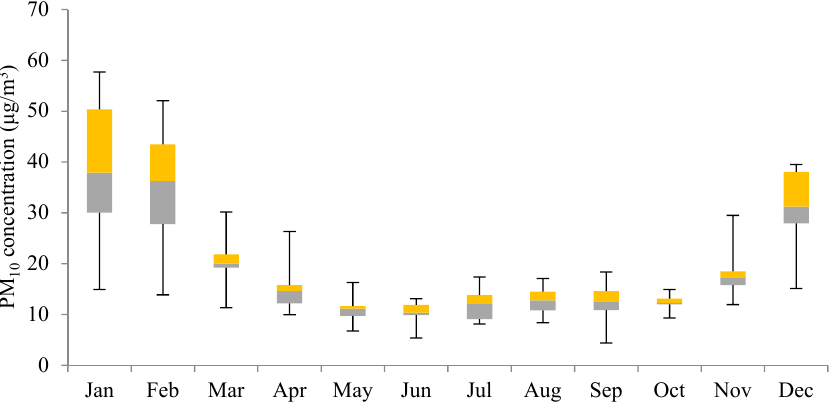
Figure 3. Box-plot analysis of monthly PM 10 concentrations (multiannual means). The lower (grey) and upper (yellow) limits represent the first (25P) and third (75P) quartiles, and the ends of the whiskers represent the minimum and the maximum values.